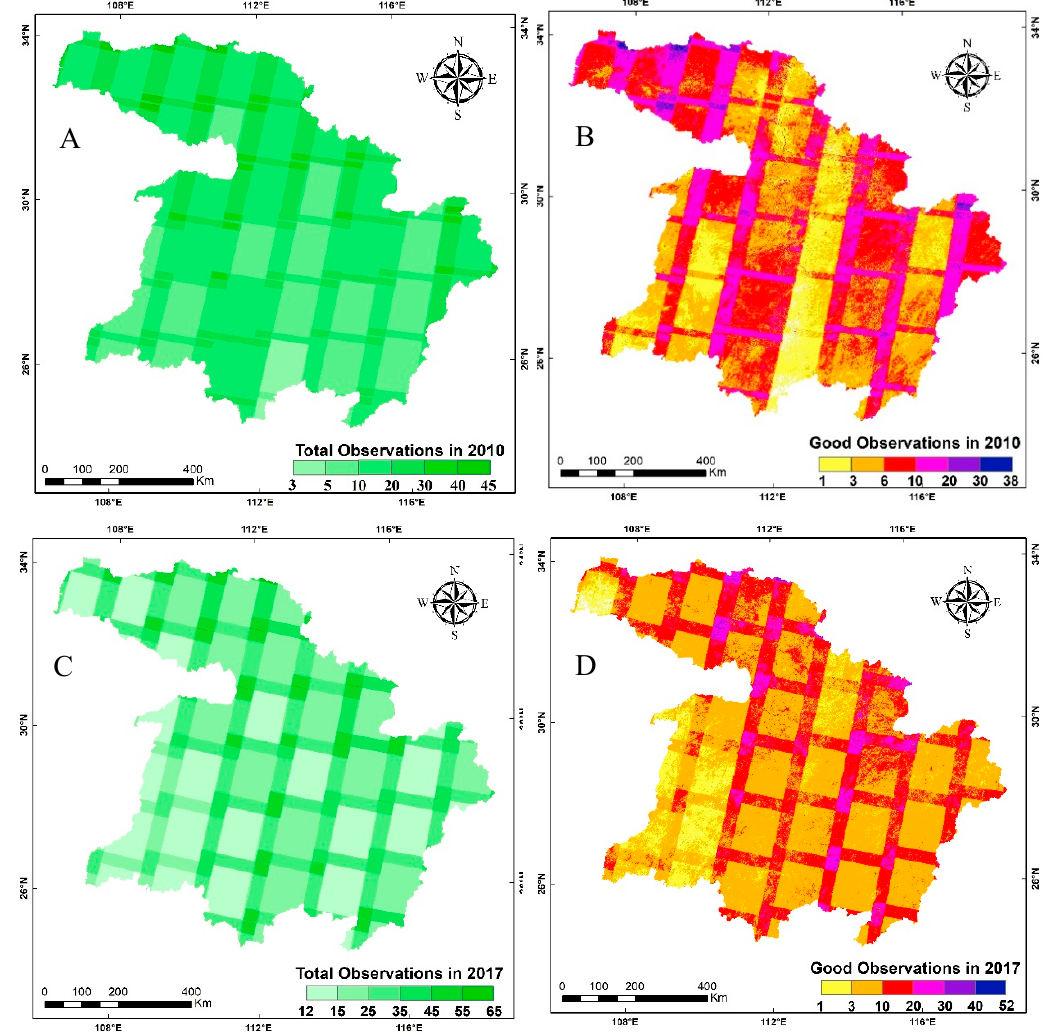
Figure 3. Spatial distribution of total observation counts and good observation counts over the MYRB in study periods: ( A ) total observation in 2017; ( B ) good observation in 2017; ( C ) total observation in 2010; ( D ) good observation in 2010. Table 2. Detail information of reference data.